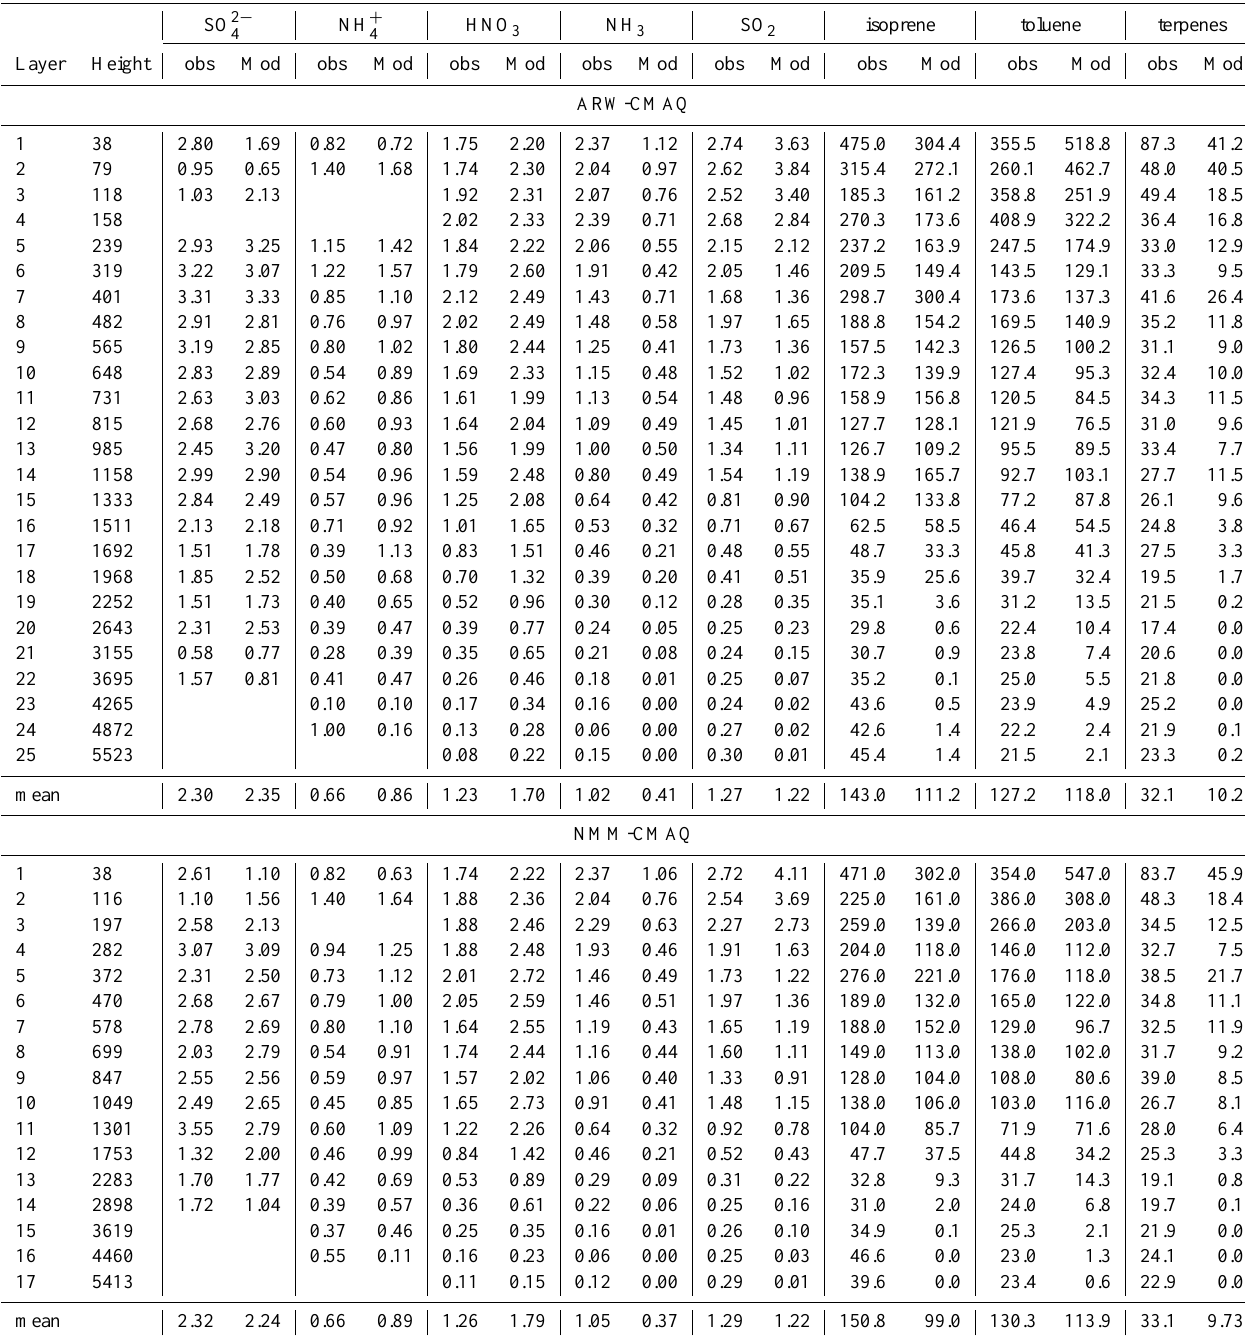
Table 4. Comparison of layer means of PM 2 . 5 (SO 2 − NMM-CMAQ) on the basis of all P3 aircraft measurements during the 2006